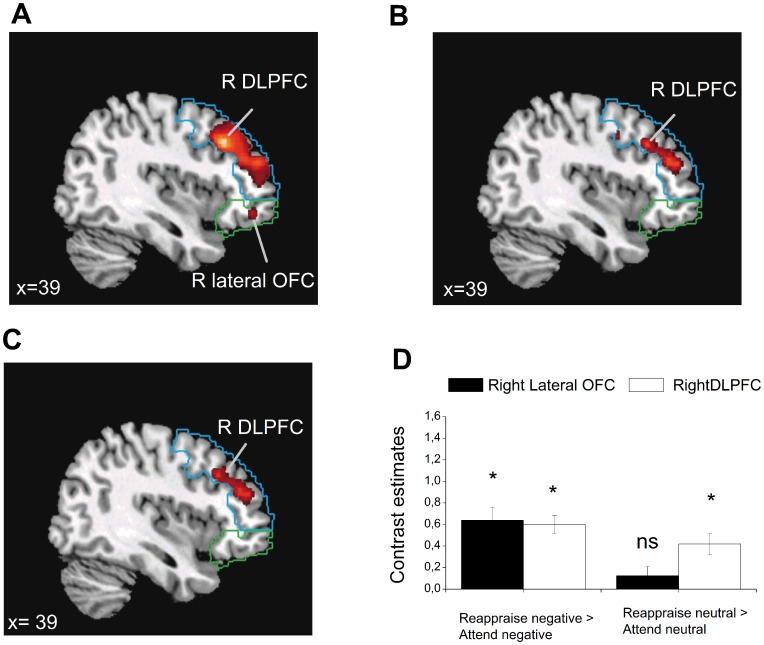
Statistical parametric maps showing activations during reappraisal of negative and neutral stimuli.(A) Activation in the right dorsolateral prefrontal cortex (DLPFC) and the lateral orbitofrontal cortex (OFC) in the Reappraise negative > Attend negative and (B) in the right DLPFC during Reappraise neutral > Attend neutral, and (C) overlapping activations in the right DLPFC in the conjunction analysis of the common effect of Reappraise negative > Attend negative and Reappraise neutral > Attend neutral. Significant activations are displayed overlaid on the DLPFC region-of-interest (ROI) image (shown in blue) and the lateral OFC ROI (shown in green) in sagittal view. (D) Contrast estimates extracted for the right DLPFC and the right lateral OFC during the Reappraise negative > Attend negative contrast [DLPFC: x = 42, y = 24, z = 39; lateral OFC: x = 42, y = 45, z = −9] and the Reappraise neutral > Attend neutral contrast [right DLPFC: x = 33, y = 43, z = 30; right lateral OFC x = 25, y = 36, z = −8]. Note that the activations were not significant for the lateral OFC in Reappraise neutral > Attend neutral or in the conjunction analysis. Activations were thresholded at p<.001 (uncorrected) for illustrative purposes and were based on the DLPFC and lateral OFC ROIs. * = p<.05 (FWE). * = p<.05 (FWE). Error bars represent standard error of the mean.